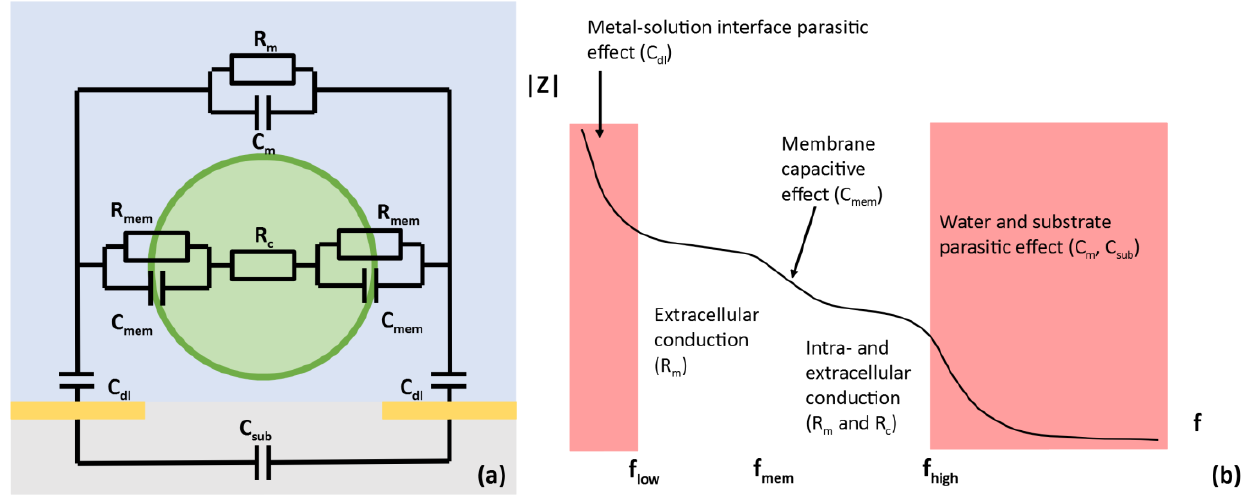
Figure 6. ( a ) The electrical model of a cell (green) inside an extracellular medium (blue) between two electrodes (yellow) on their substrate (gray). ( b ) The typical impedance spectrum of a cell is limited by the parasitic effects of the electrodes and the environment.